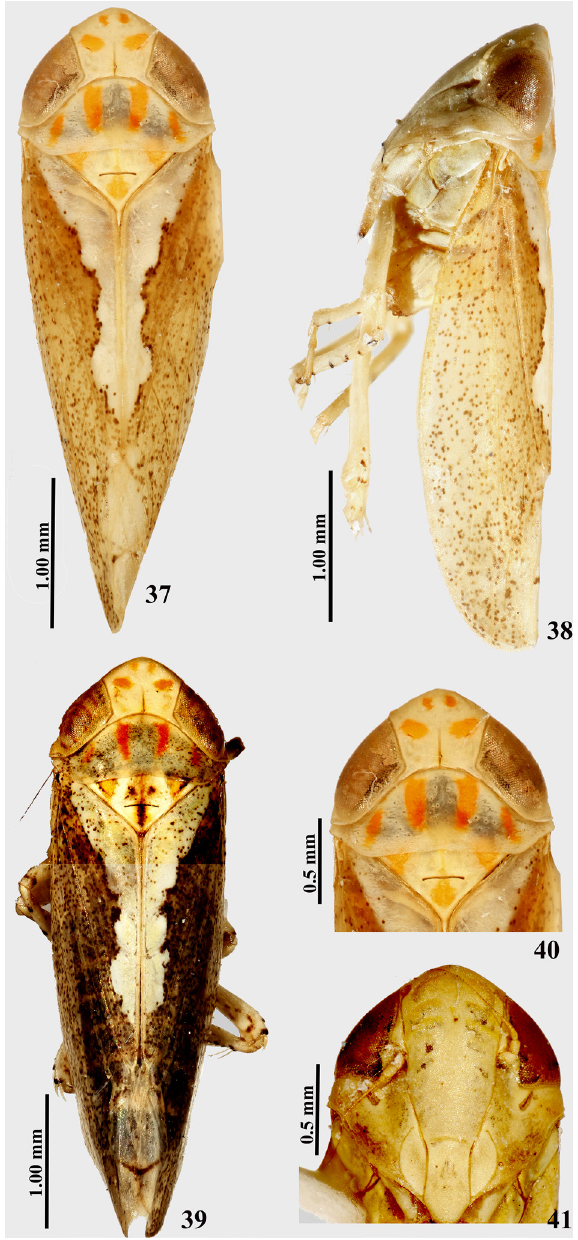
Figs 37−41. Oshaibahus linnavuorii El-Sonbati & Wilson gen et sp. nov. 37 , 39 . Dorsal view. 38 . Lateral view. 40 . Dorsal view of head and thorax. 41 .